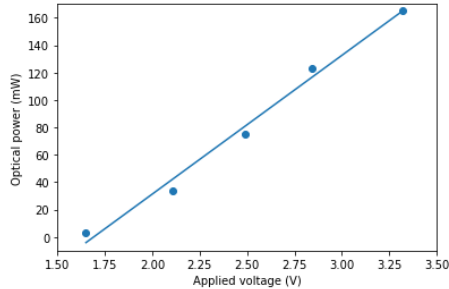
Fig 2. Optical power curve of the